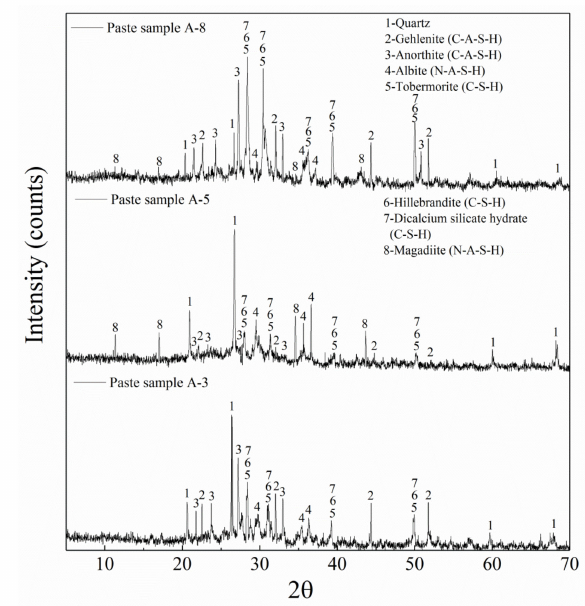
Figure 4. XRD (X-ray diffraction) analysis of paste samples A-3, A-5, and A-8. Different kinds of mineral crystals formed in sample A-3, for which, NaOH was used as sole initiator at different dosages. The characteristic peaks of quartz (1; SiO 2 , and PDF #46-1045) appeared, which were marked as 1 and the intensity of the charac- teristic peak was very high. This indicates that sample A-3 contains a large number of quartz crystals. However, quartz crystals did not form by polymerization, and are mainly carried in BA and have low polymerization activity. At the same time, the characteris- tic peaks of gehlenite (2CaO · Al 2 O 3 · SiO 2 ; PDF #35-0755) and anorthite (CaO · Al 2 O 3 · SiO 2 ; PDF #41-1486) appeared in sample A-3, marked as 2 and 3, respectively. Gehlenite